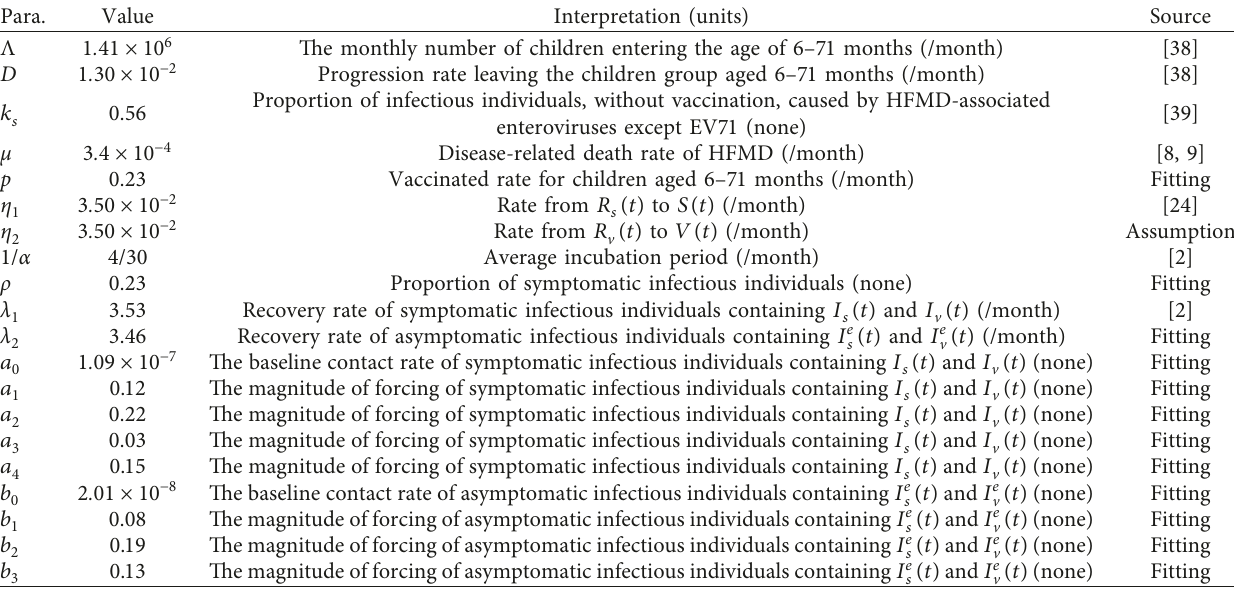
Table 1: Descriptions and values of parameters in system